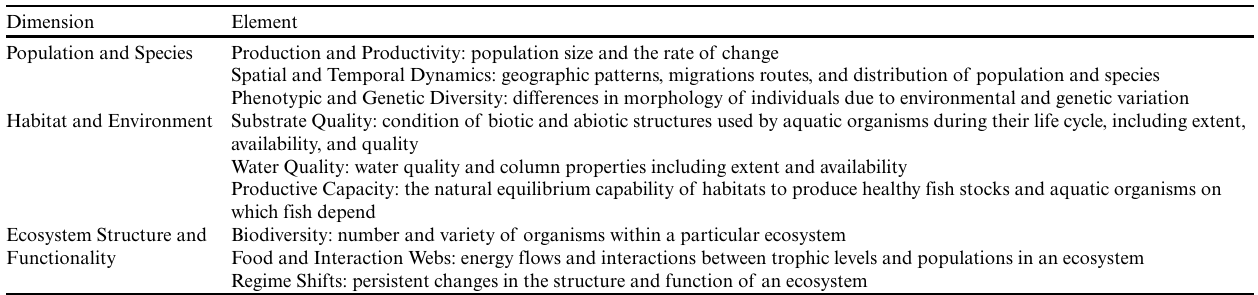
Table 2 . Elements in the ecological domain.